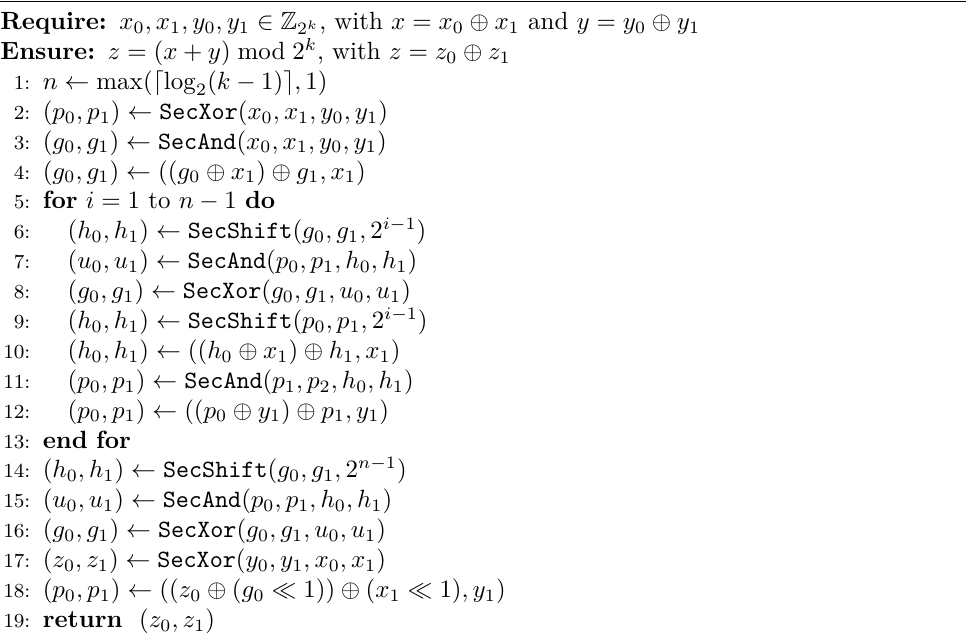
Algorithm 12 Kogge-Stone Masked Addition